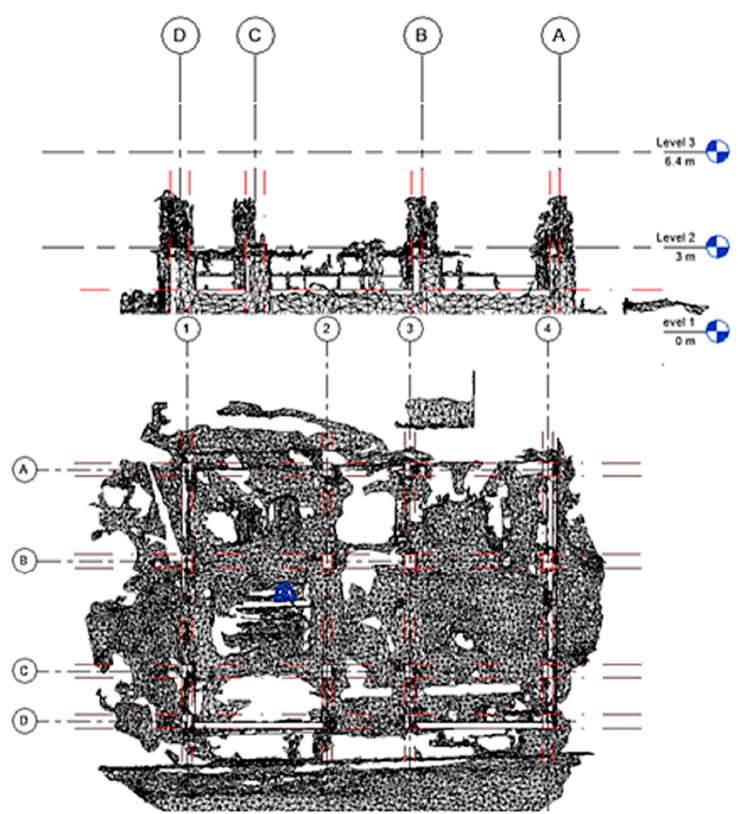
Figure 8. Generated as ‐ built model using reference lines and mesh model in Autodesk Revit.